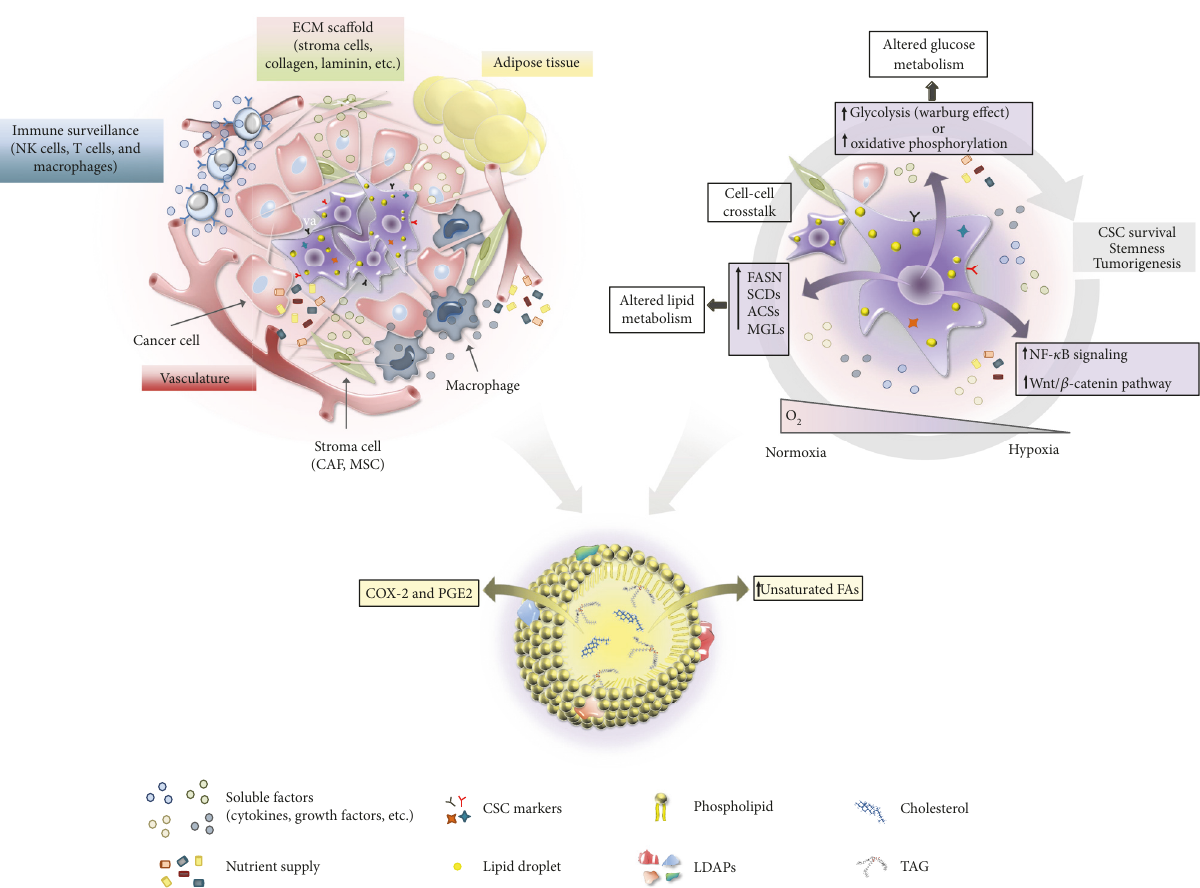
Figure 4: The schematic model depicts the hypothetic CSC niche (on the left) in human tumors. The main elements are summarized: (i) the cellular components, such as CSCs, cancer cells, adipocytes, immune cells, and stroma cells [e.g., cancer-associated fi broblasts (CAFs) and mesenchymal stem cells (MSCs)]; (ii) ECM components: collagen, laminin, and so forth; and (iii) soluble factors (growth factors, proin fl ammatory cytokines, chemokines, exosomes, etc.) release from di ff erent cell types and nutrient supply from vasculature. A CSC (on the right) shows higher amount of LDs compared with other cells. Within tumor bulk, hypoxia develops due to limited vascularization. A continuous interplay among di ff erent factors inside the niche, including hypoxic/normoxic conditions, nutrient supply availability, the release of soluble factors, and cell ‐ cell interactions contributes to determine the CSC properties and in fl uences their metabolic plasticity, as reviewed in [143, 163, 166, 174]. A single cancerous LD (bottom) is also schematically represented, based on [121,